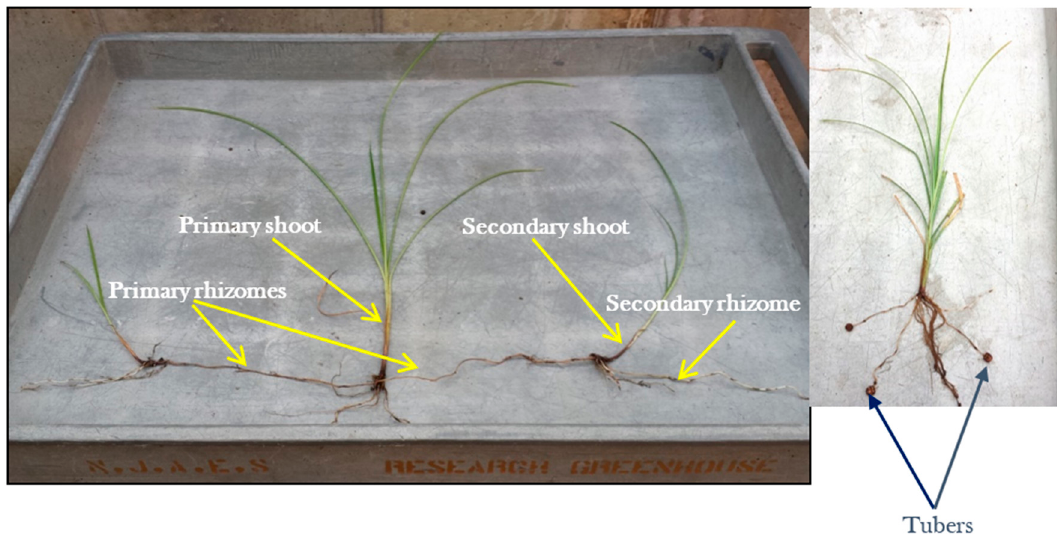
Figure 4. Tigernut growth habit (Photos: Albert Ayeni).